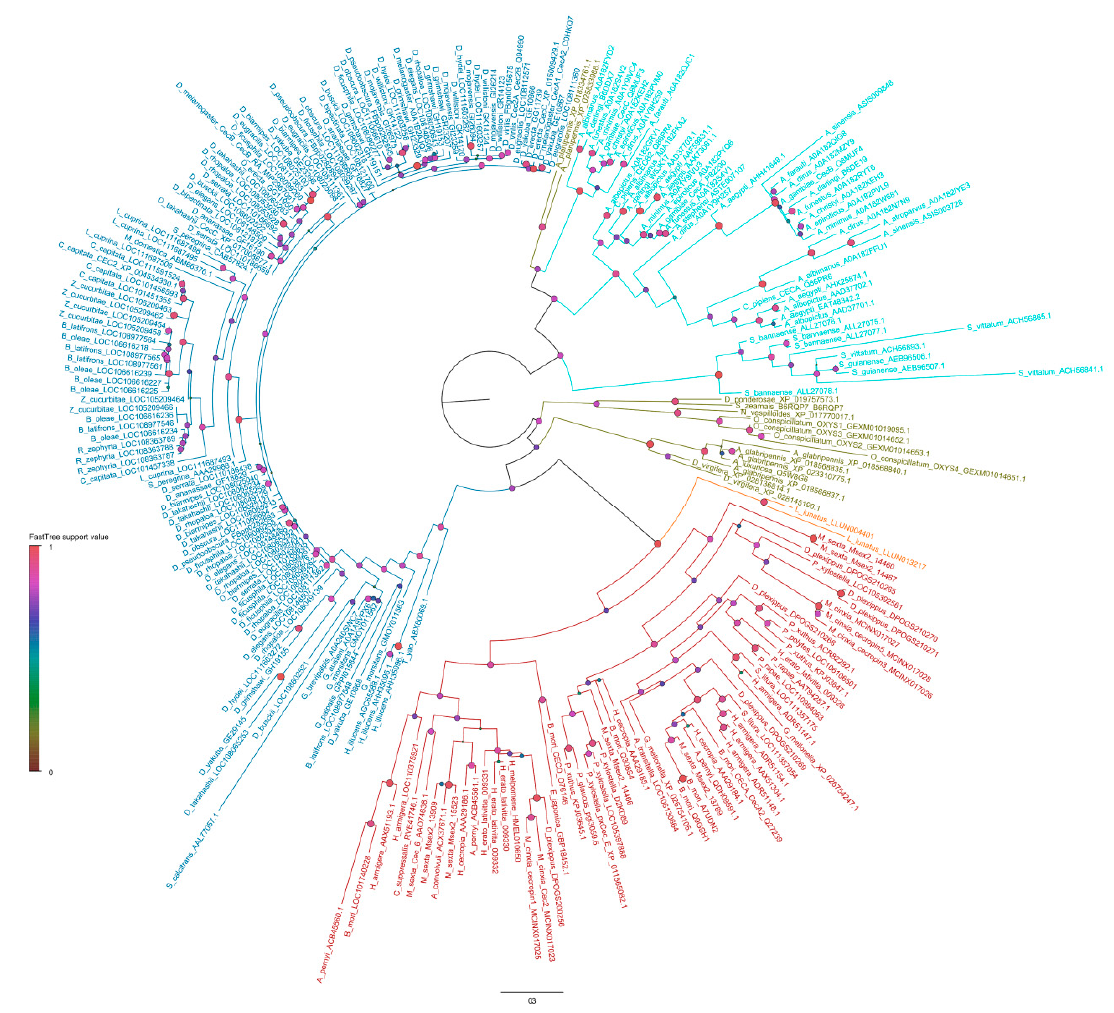
Figure 1. Phylogenetic tree of insect Cecropins (Cecs) and Cec-like peptides. Maximum likelihood mid-point rooted phylogenetic tree showing the relationships of insect Cecs and Cec-like peptides. The tree was obtained with FastTree 2.1.5 software with the WAG + Γ model [81]. Lepidoptera peptides are shown in red, Trichoptera in orange, Diptera Brachycera in dark blue, Diptera Culicomorpha in light blue, and Coleoptera in green. Full-length Cecs and Cec-like peptides were downloaded from the OrthoDB database (Available online: https://www.orthodb.org/), which contains 230 sequences in 61 species of Lepidoptera and Diptera. Other sequences, including those from Simulium , Trichoptera, and Coleoptera, were downloaded from NCBI and UniprotKB. Sequences were aligned with ClustalW using default parameters in Geneious 8.1.9 (BioMatters). Identical sequences within species were removed leaving a total of 254 Cecs and Cec-like peptides. Either UniprotKB or NCBI accession number are reported for each sequence in the tree. Circle at the nodes indicate node support obtained with Shimodaira–Hasegawa-like local support. Shade (as shown in the legend) and circle size are proportional to the node support value (0–1). The scale bar corresponds to estimated amino acid substitutions per site.